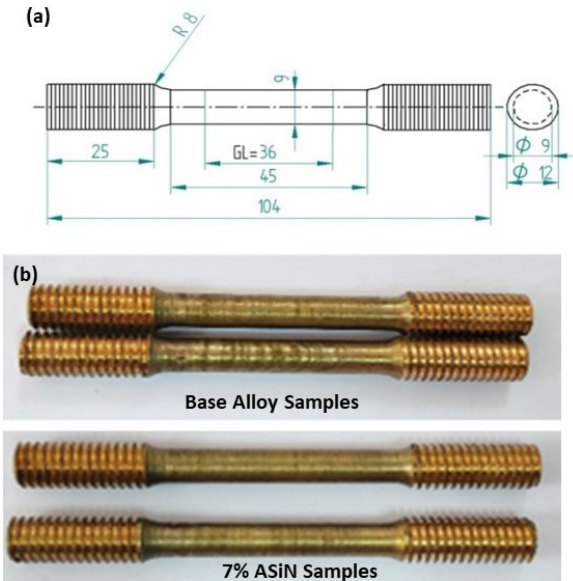
Figure 4: (a) Dimensions of tensile test specimen in mm as per ASTM 10-18 and (b). Tensile test specimens as per ASTM 10-18.